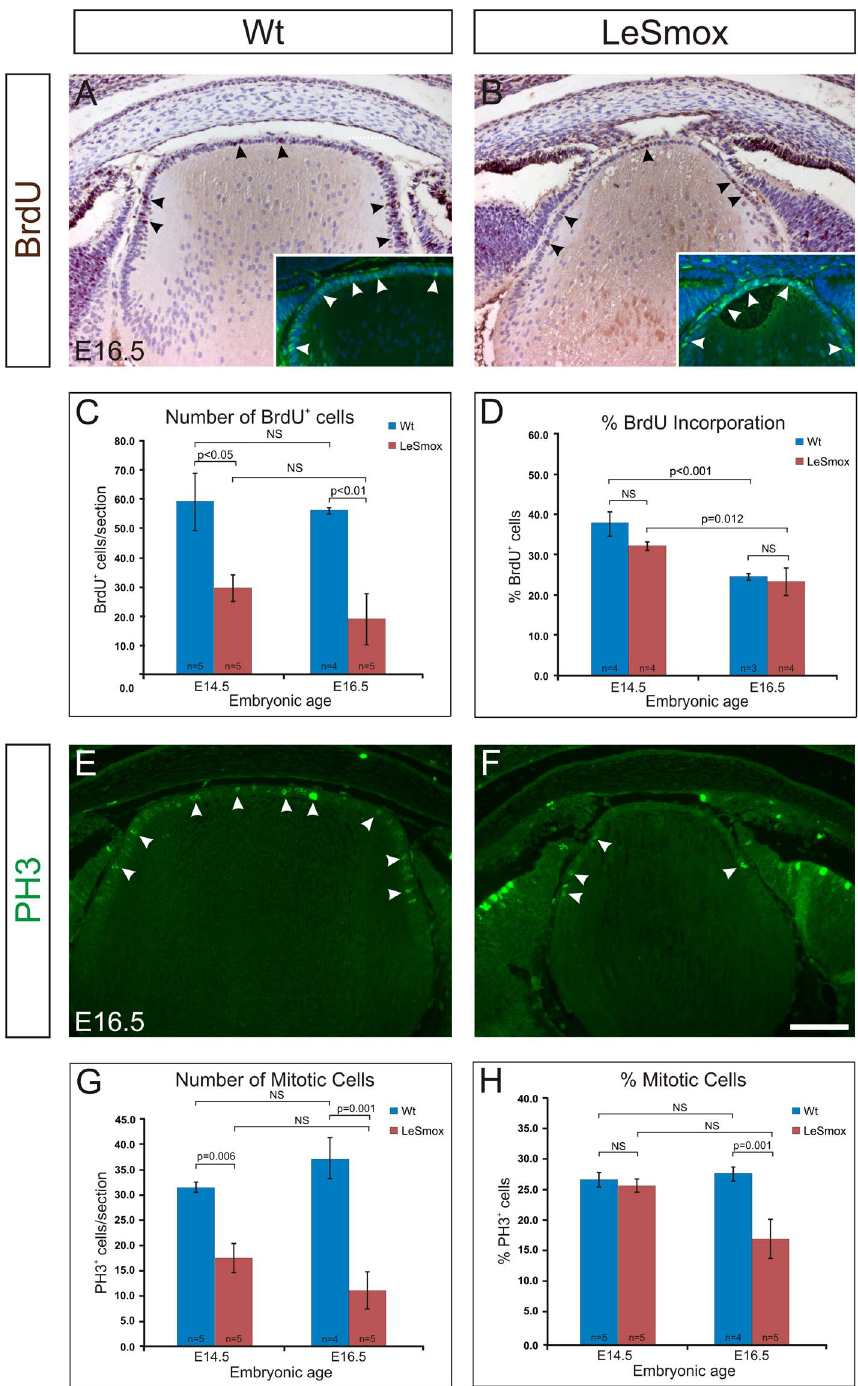
Figure 8. Epithelial cell proliferation in LeSmox lenses. BrdU labelling in wild-type ( A ) and LeSmox ( B ) lenses reveals numerous BrdU + nuclei in the epithelial layer (black arrowheads). Consistent with this, numerous cyclin D1 + nuclei are detected (insets A, B; white arrowheads). Immunolabelling for phospho-histone-3 (PH3) reveals numerous PH3 + nuclei in the wild-type ( E ) but reduced labelling in the LeSmox ( F ) lenses. Quantification of BrdU + ( C ) and PH3 + ( G ) nuclei revealed significant changes in the total numbers of positive cells in each section. However, quantification of the percentage of cells labelled ( D, H ) indicated no significant changes in BrdU incorporation ( D ) but significantly reduced PH3 labelling index in LeSmox lenses at E16.5 compared to Wt ( H ). Scale bar, A, B, E, F, insets , 100 m m.